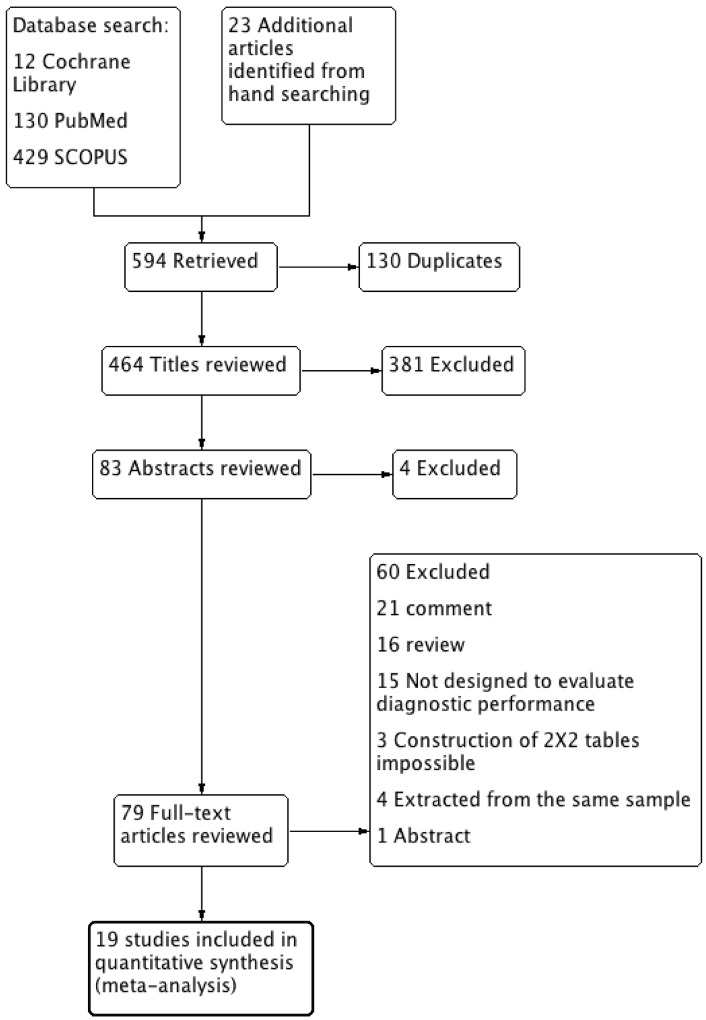
PRISMA flowchart.